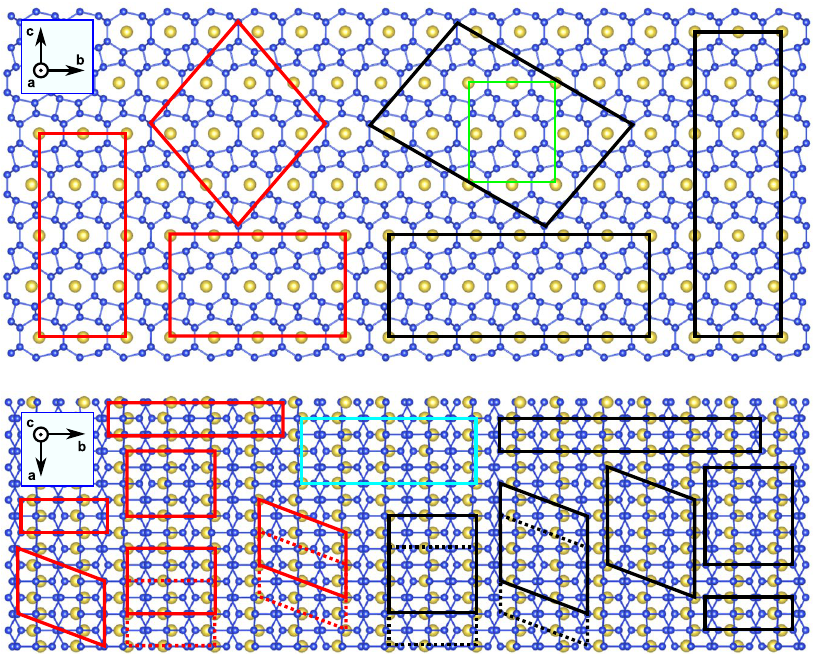
Figure 1. Structure of Na 4 Si 24 projected in b - c and a - b planes. The parallelograms indicate all of the supercells used to generate different Na x Si 24 configurations when sodium atoms are removed from the structure. Red, black, and light blue parallelograms correspond to supercells containing 8, 12, and 16 formula units, respectively. The green rectangle shows the unit cell, with 4 formula units. Blue and yellow balls stand for silicon and sodium atoms,